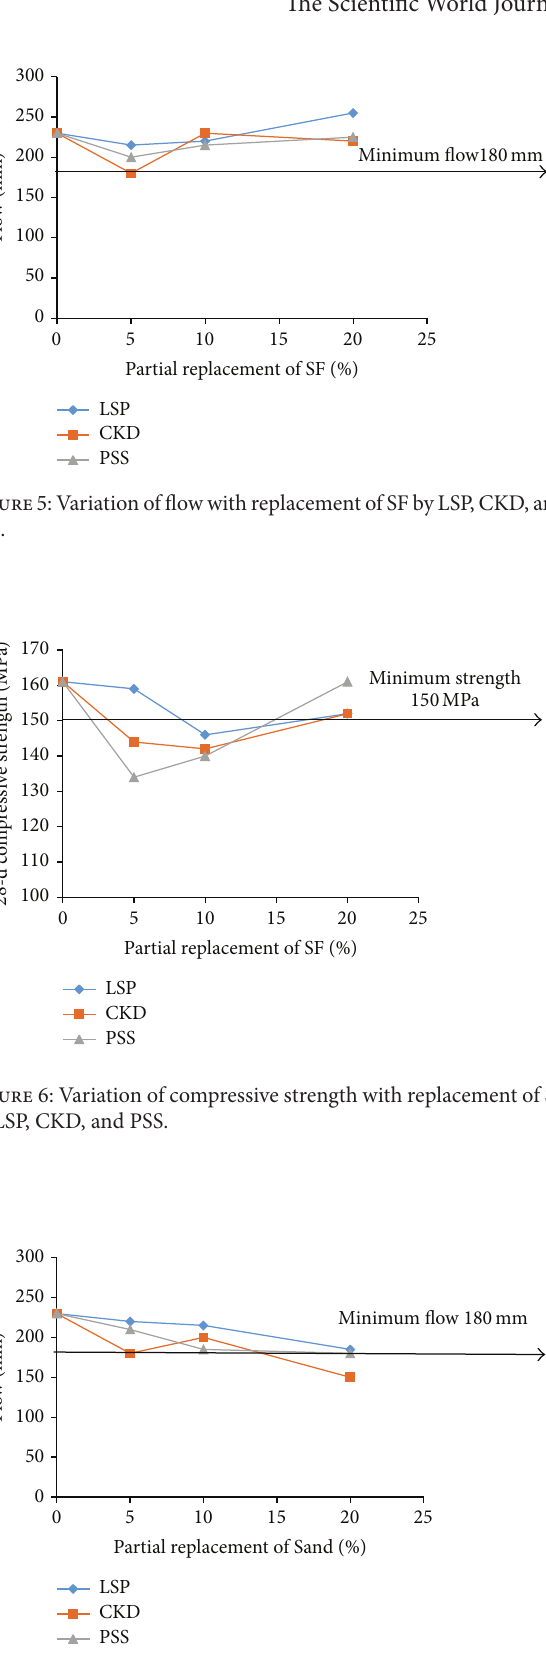
Figure 7: Variation of flow with replacement of sand by LSP, CKD, and